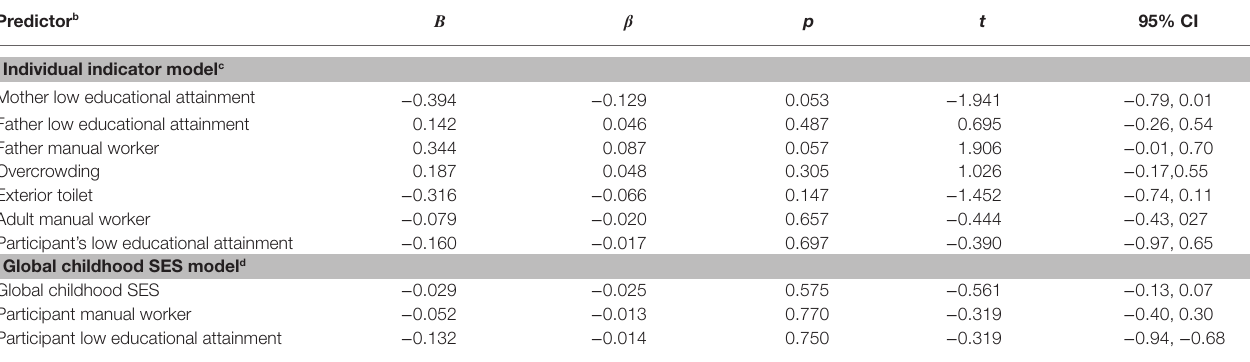
TABLE 5 | Multiple regression analyses results for cognitive decline a based on childhood SES with adult SES covariates among individuals aged 69.8 and 76.7 years. Predictor b Β β p t 95% CI Individual indicator model c